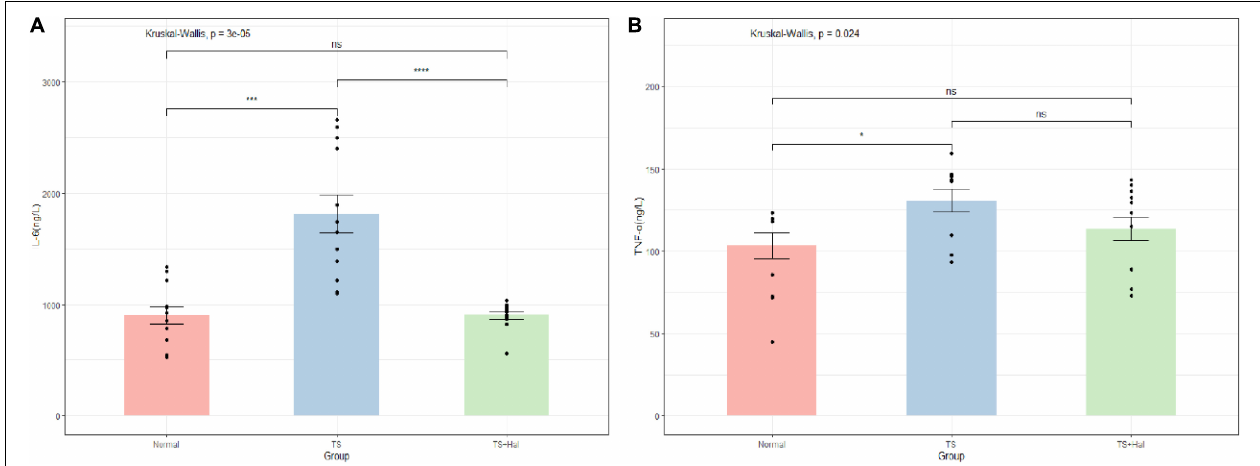
FIGURE 2 | (A) Comparison of IL-6 levels in the brain of each group; (B) comparison of TNF- α levels in the brain of each group. TS, Tourette syndrome; TS + Hal, TS + haloperidol group; ns, not significant; (cid:70) (cid:70) (cid:70) (cid:70) : P < 0.0001; (cid:70) (cid:70) (cid:70) : P < 0.001; (cid:70) : P < 0.1.